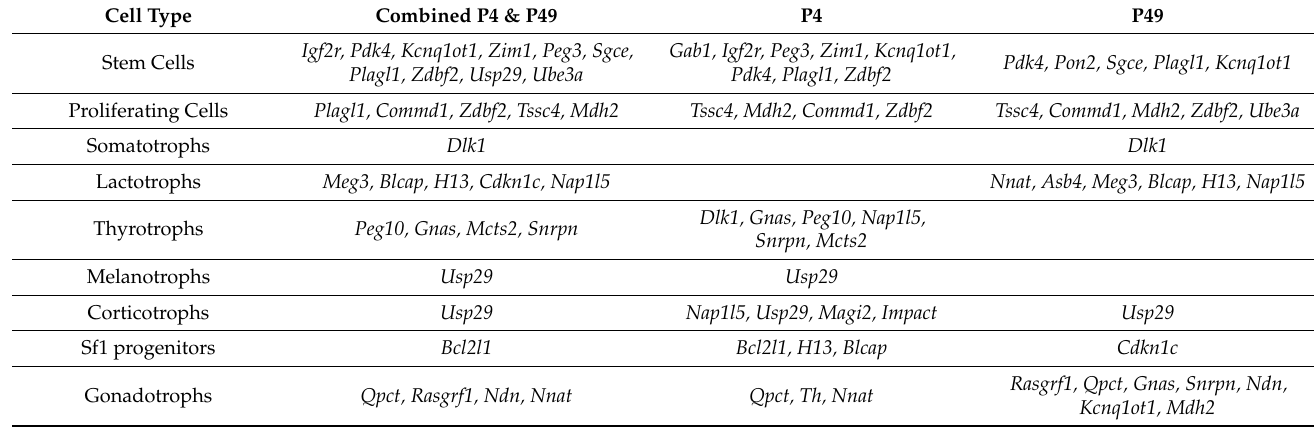
Table 2. Enriched imprinted genes in single-cell RNA sequencing (scRNAseq) postnatal AP cell types. Identification of differentially expressed (DE) imprinted genes (IGs) was carried out on the combined-age data (postnatal day 4 (P4) and postnatal day 49 (P49) together), and a subset of P4 and P49, respectively. Significant DE IGs were reported if p _val_adj ≤ 0.05 and avg_logFC ≥